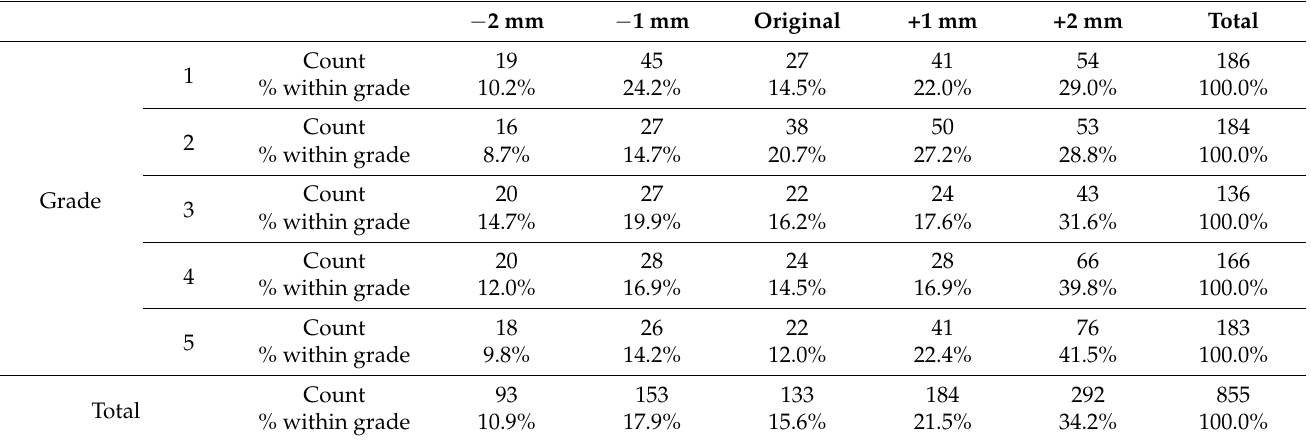
Table 4. Distribution of preferences across grades regarding the sagittal position of the maxillary arch (SPM, photo series No.